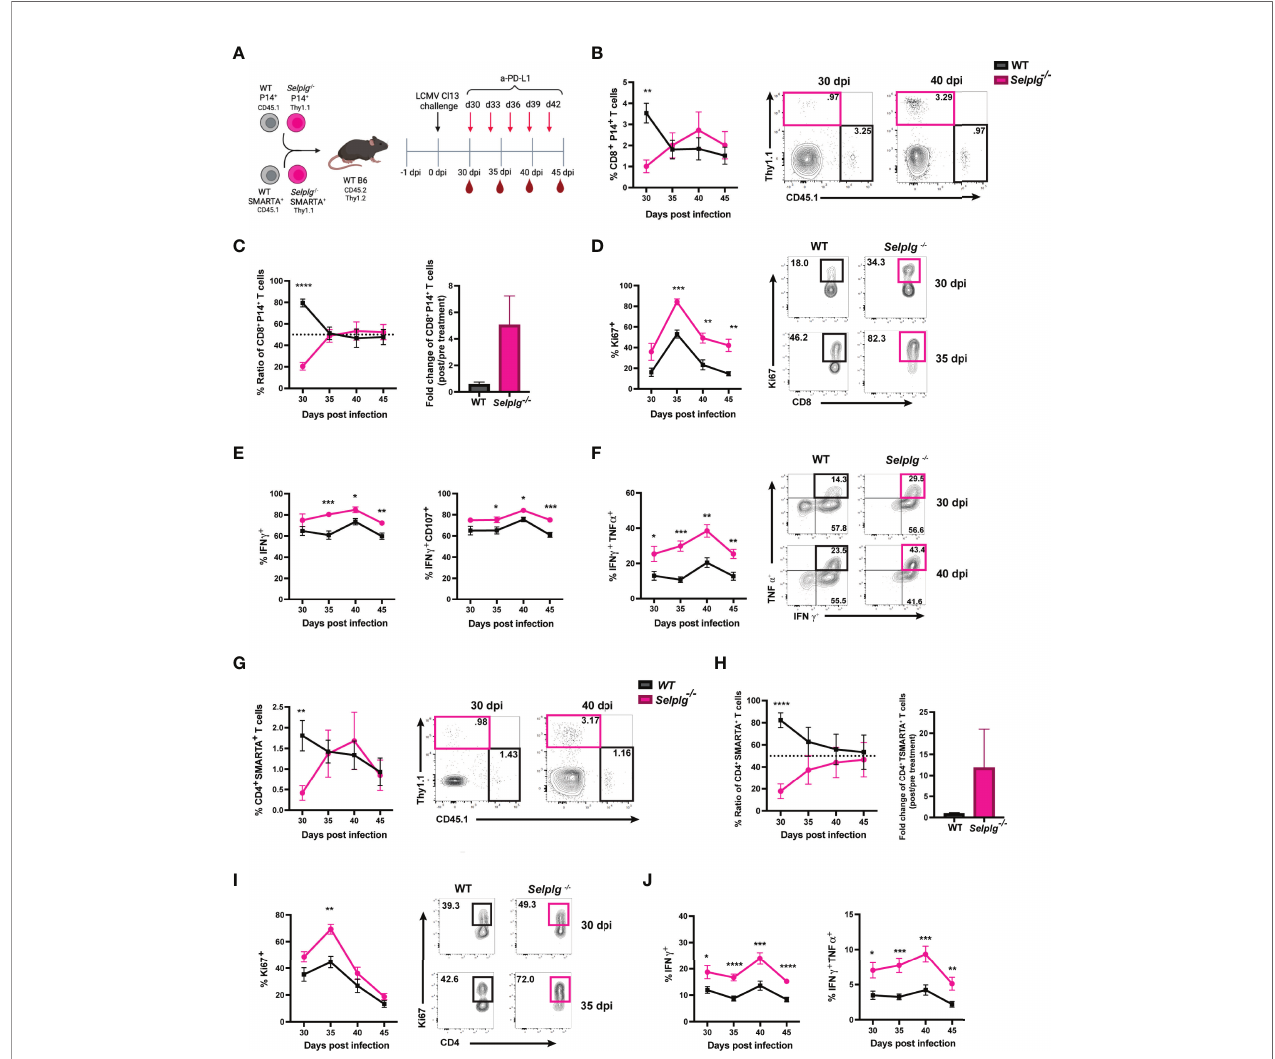
FIGURE 5 | PD-L1 blockade synergizes to reinvigorate Selplg -/- CD4 + and CD8 + T cells. Anti-PD-L1 blockade experimental approach (A) . Frequencies of WT and Selplg -/- P14 + T cells before (30dpi) and after anti-PD-L1 treatment (B) . Ratio and fold change of WT and Selplg -/- P14 + T cells before (30dpi) and after (40dpi) anti-PD-L1 treatment (C) . Frequencies of Ki67 + (D) , IFN- g + and IFN- g + CD107 + (E) , and IFN- g + TNF- a + (F) of WT and Selplg -/- P14 + T cells. Frequencies of WT and Selplg -/- SMARTA + T cells before (30dpi) and after anti-PD-L1 treatment (G) . Ratio and fold change of WT and Selplg -/- SMARTA T cells before (30dpi) and after (40dpi) anti-PD-L1 treatment (H) . Frequencies of Ki67 + (I) and IFN- g + and IFN- g + TNF- a + (J) of WT and Selplg -/- SMARTA + T cells. *p < 0.05, **p < 0.01, ***p < 0.005 ****p < 0.001, (unpaired t -test). Data are representative of three independent experiments all with fi ve or more mice per group (error bars,